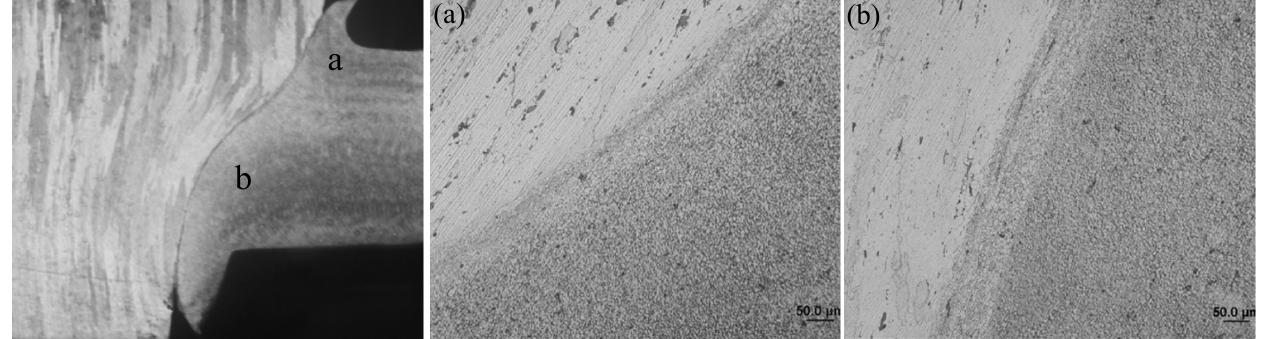
Figure 11. Material flow direction of FPW joint along the parallel direction of FSW: ( a ) top of the nugget, and ( b ) bottom of the nugget.